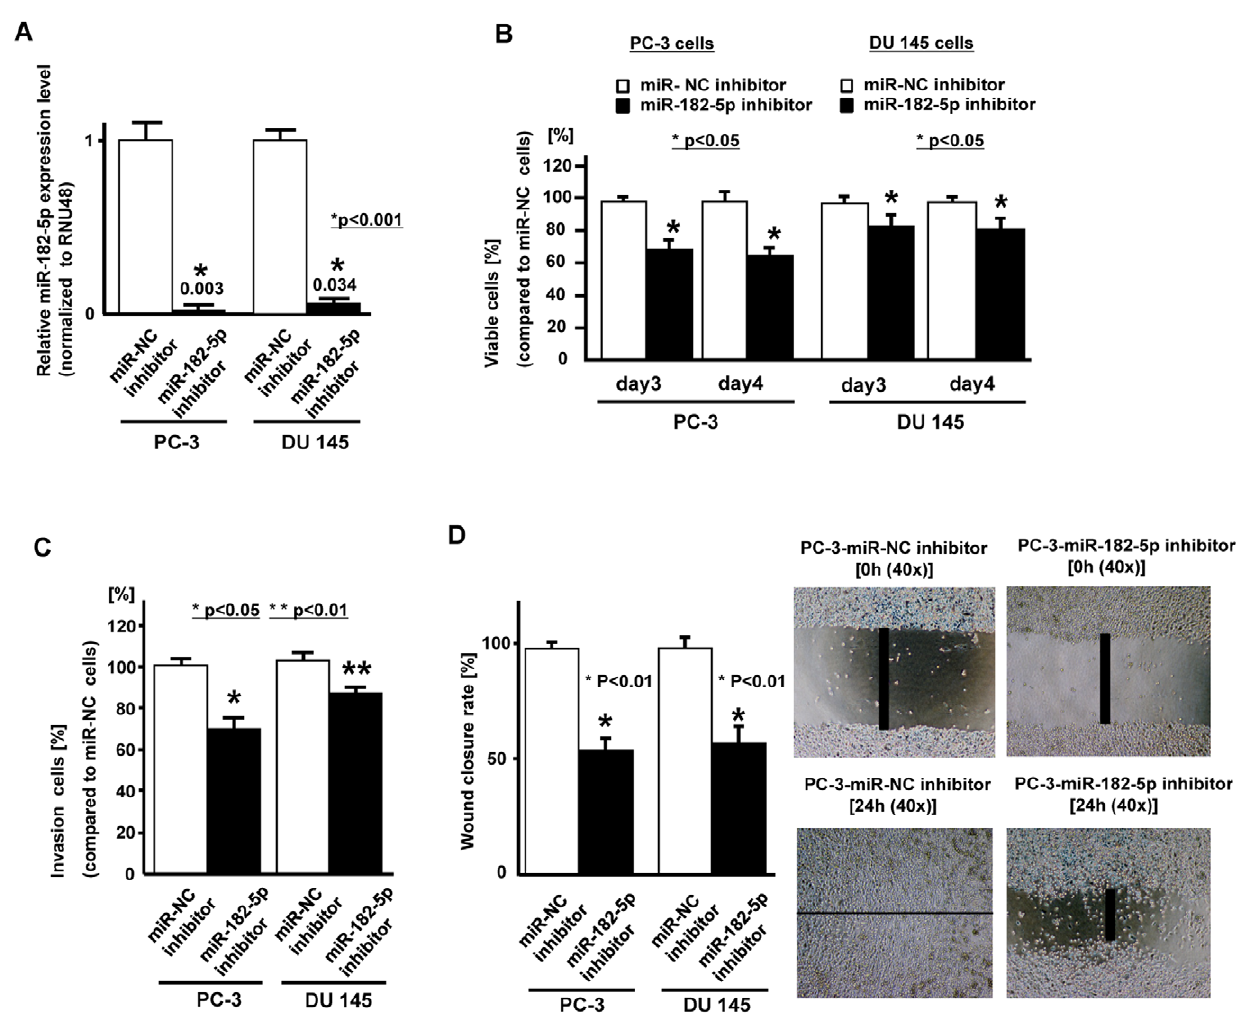
Figure 3. Effect of miR-182-5p knock down on prostate cancer cells (PC-3, DU145). Two prostate cancer cell lines (PC-3 and DU145) were transiently transfected with either miR-182-5p inhibitor or miR-negative control (miR-NC-inhibitor). A. Relative miR-182-5p expression (miR-NC inhibitor or miR-182-5p inhibitor transfected PC cells), B. Cell viability assay (miR-NC inhibitor or miR-182-5p inhibitor transfected PC cells), C. Invasion assay, D. Wound healing assay (24 hours). Error bars represent 6 S.D. (standard